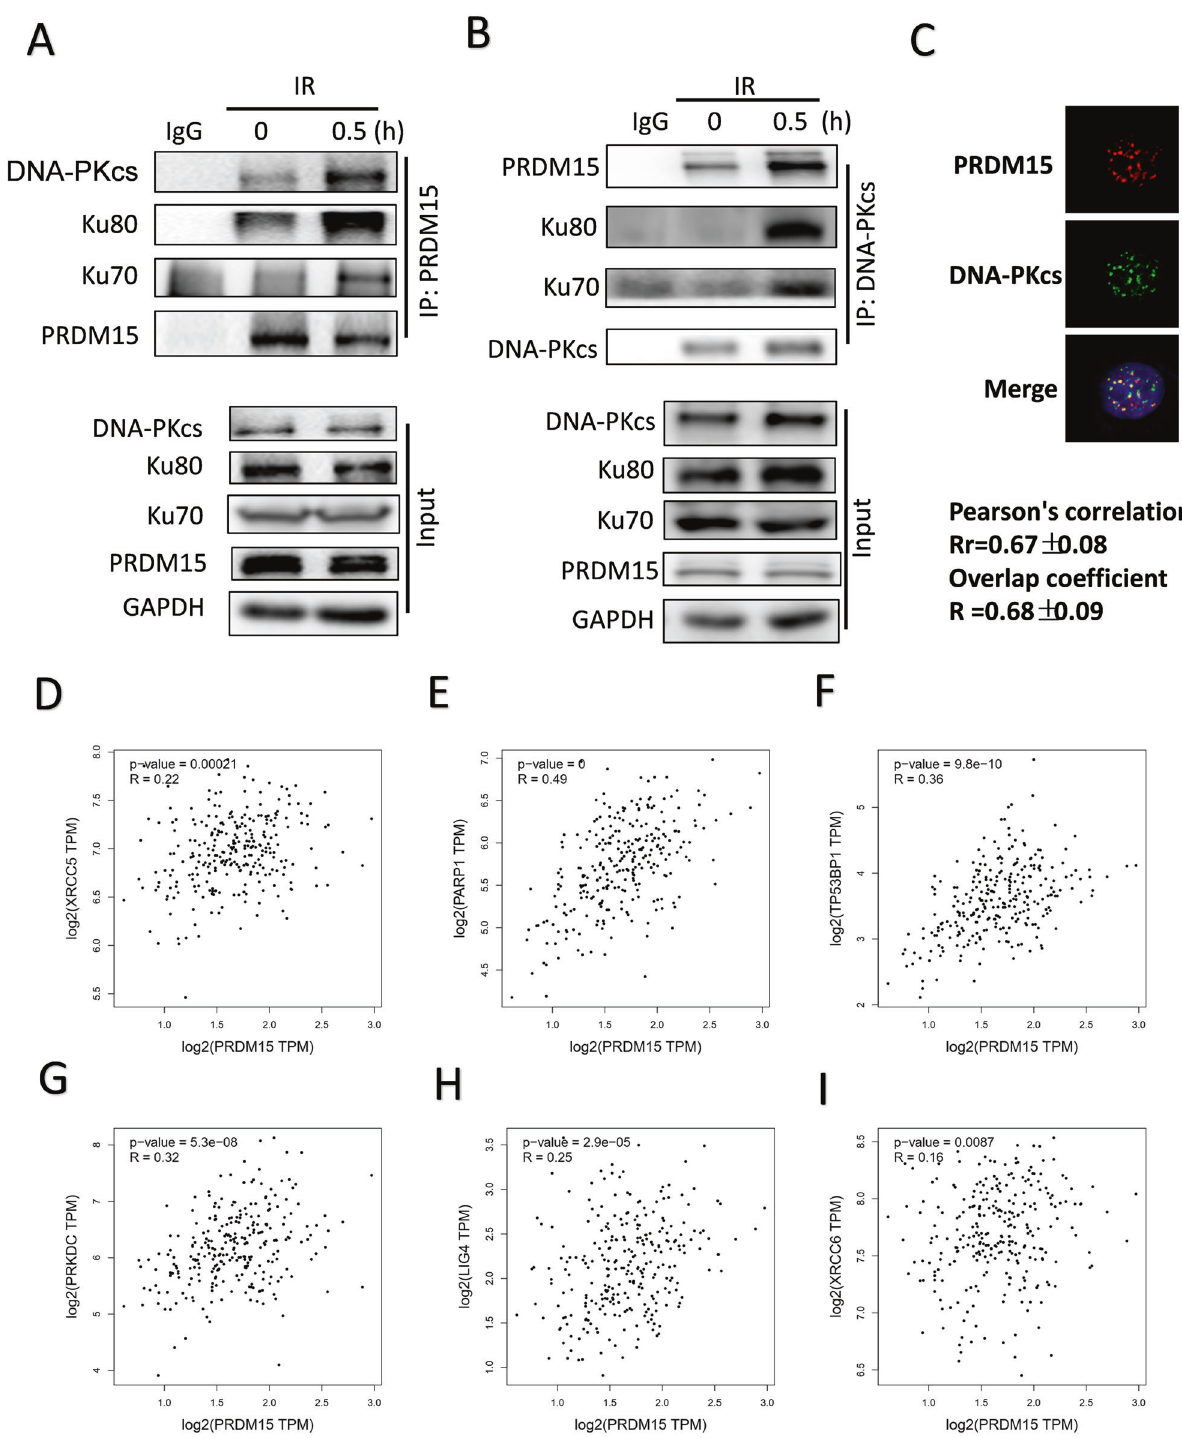
Fig. 5 PRDM15 regulates NHEJ repair by interacting with Ku70/80. A Ku70, Ku80, and DNA-PKcs were immunoprecipitated by PRDM15 in lysates of irradiated HCT116 cells. B PRDM15 was immunoprecipitated by DNA-PKcs in lysates of irradiated HCT116 cells. C The representative IF images and quanti fi cation of co-localization of PRDM15 with DNA-PKcs. HCT116 cells at 0.5 h after IR were used for immuno fl uorescence staining. Confocal microscopy was applied to capture co-localization, and Image J was used to analyze the statistical signi fi cance of co- localization. Rr represents Pearson ’ s correlation coef fi cient and R represents Overlap coef fi cient. Pearson correlation coef fi cient of 0.5-1 is considered as co-localization. D – I Bioinformatics analysis of the correlation between PRDM15 and genes related to NHEJ pathway. survival in CRC patients, suggesting PRDM15 as a factor of poor from the TCGA database also showed that PRDM15 was prognosis (Fig. 8B). associated with colorectal cancer. PRDM15 expression in colon Then we detected its clinical relevance through using clinical adenocarcinoma was higher than that in normal tissues (Fig. 8A). samples collected in our department. Firstly, 80 patients who received PRDM15 was also found to be negatively correlated with overall Cell Death and Disease (2022)